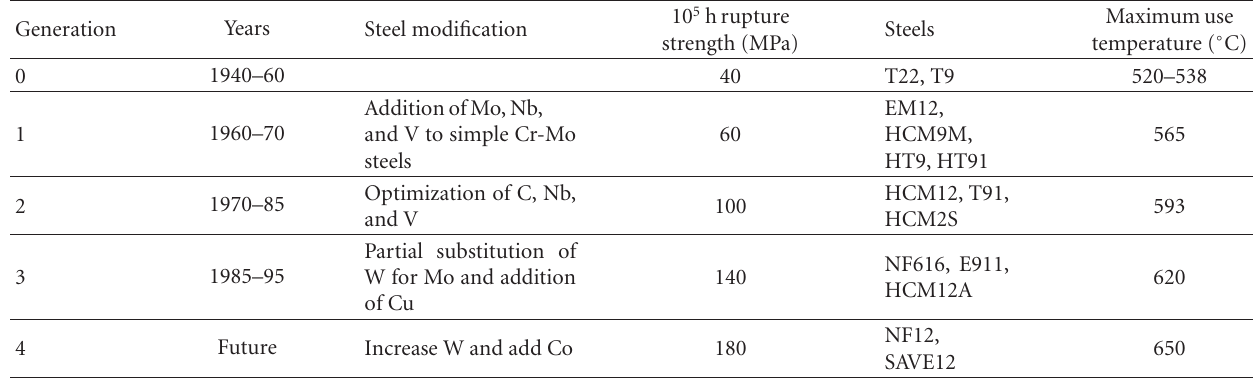
Table 1: Evolution of ferritic/martensitic steels for power-generation